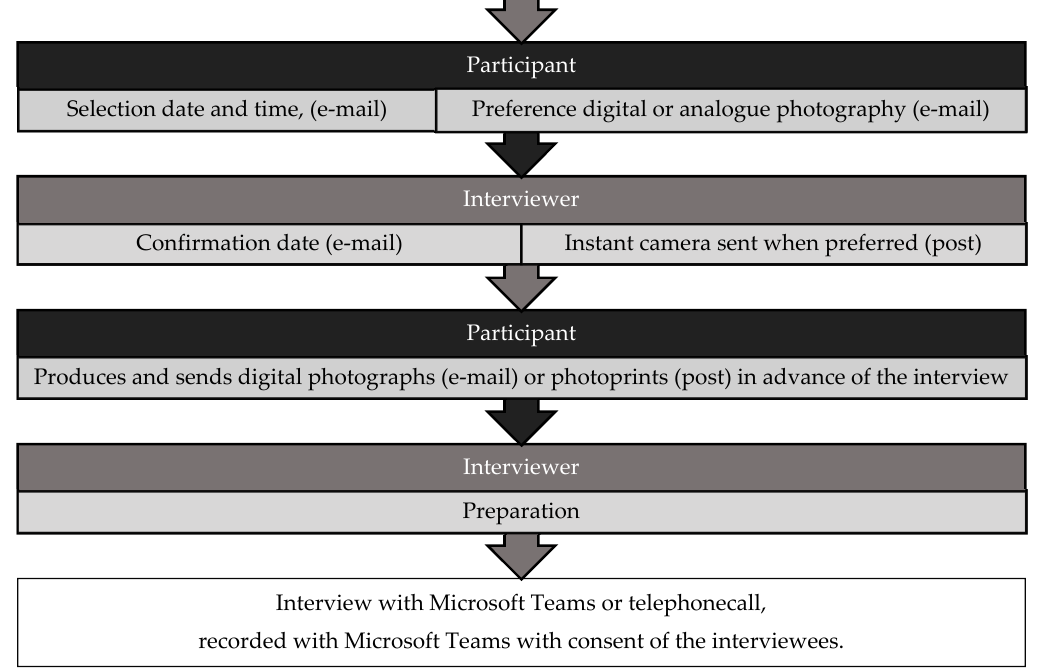
Figure 2. Procedure. Figure 2.